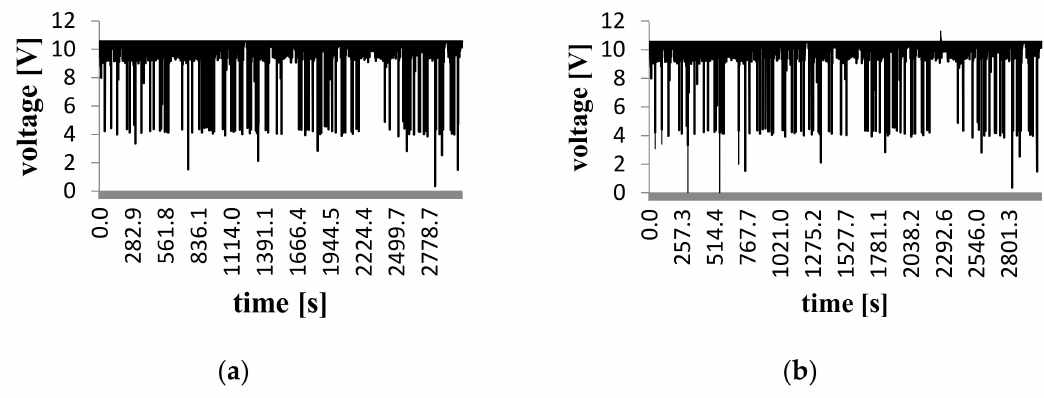
Figure 11. Fuel cell voltage characteristics during normal state. Measurements of the physical object ( a ), simulation ( b